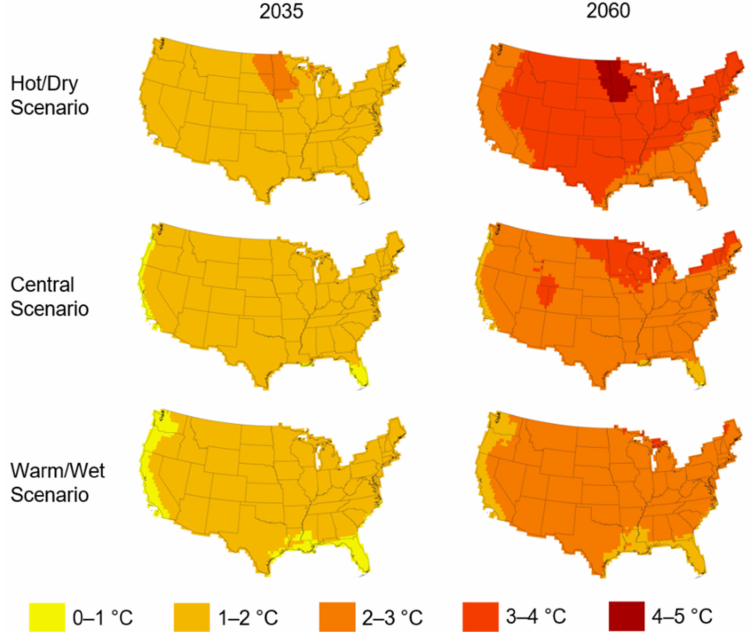
Figure 2. Projected changes in average annual temperature.